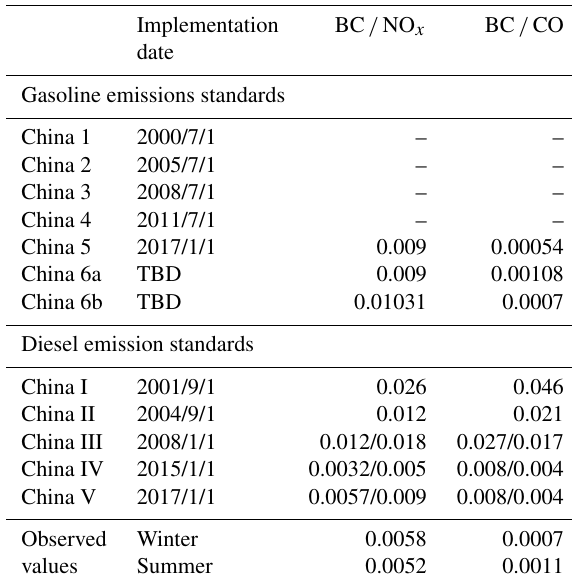
Table 3. Estimated ratios of BC / NO x and BC / CO for gaso- line engines and diesel engines. An overview of on-road vehicu- lar emissions and their control in China by Wu et al. (2017) sum- marised NO x , CO and PM 2 . 5 emission regulation targets in China. The BC / PM 2 . 5 fractions for gasoline were taken from European guideline of emissions controls, as such fractions are not available for China. Since PM 2 . 5 controls for LDGVs were only introduced recently within China 5 controls, our estimates could not be per- formed according to previous standards. Observed values corre- spond to ratios shown in Fig. 10. Dates are given in yyyy/mm/d. TBD denotes standards that are “to be